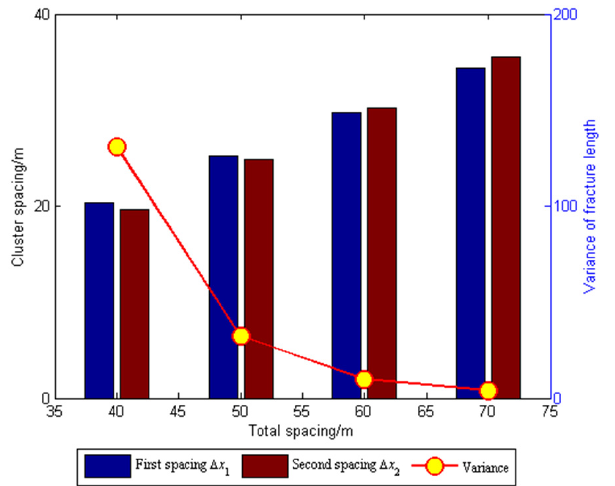
Figure 7. The optimized cluster spacings and corresponding variances for three-cluster fracturing.